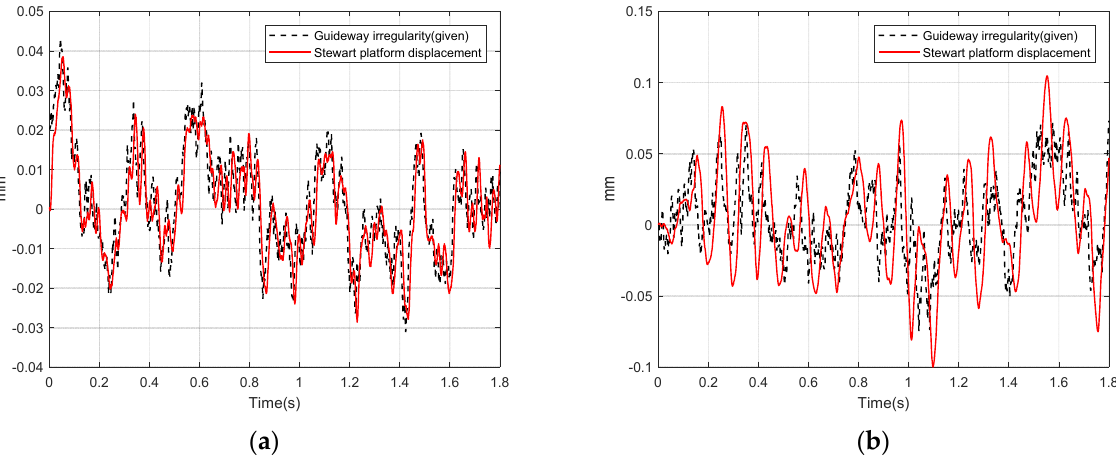
displacement, ( b ) lateral displacement.